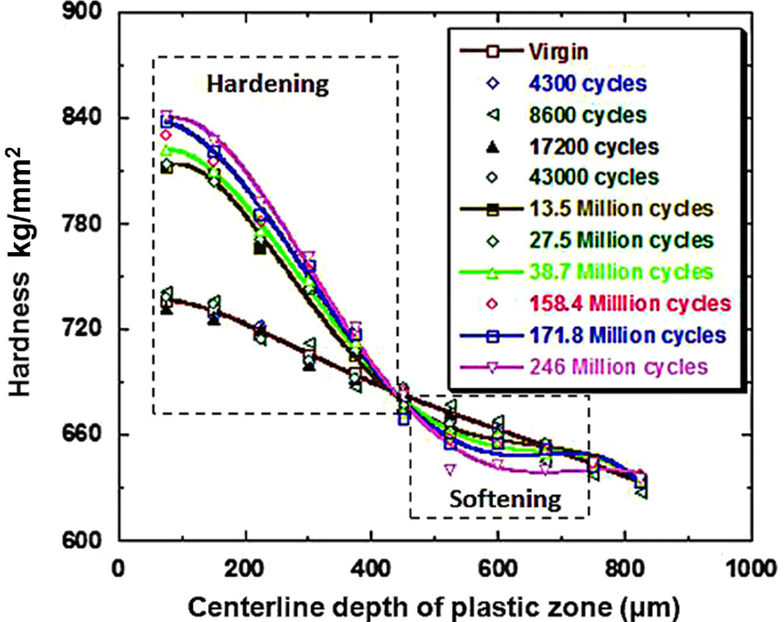
Figure 4. The centreline hardness is shown as a function of depth. Hardening takes place at a depth of nearly 450 µm. A softened region can also be observed at 500–700 µm depth. Maximum harden- ing can be observed after 246 million RCF cycles [35]. can be observed after 246 million RCF cycles